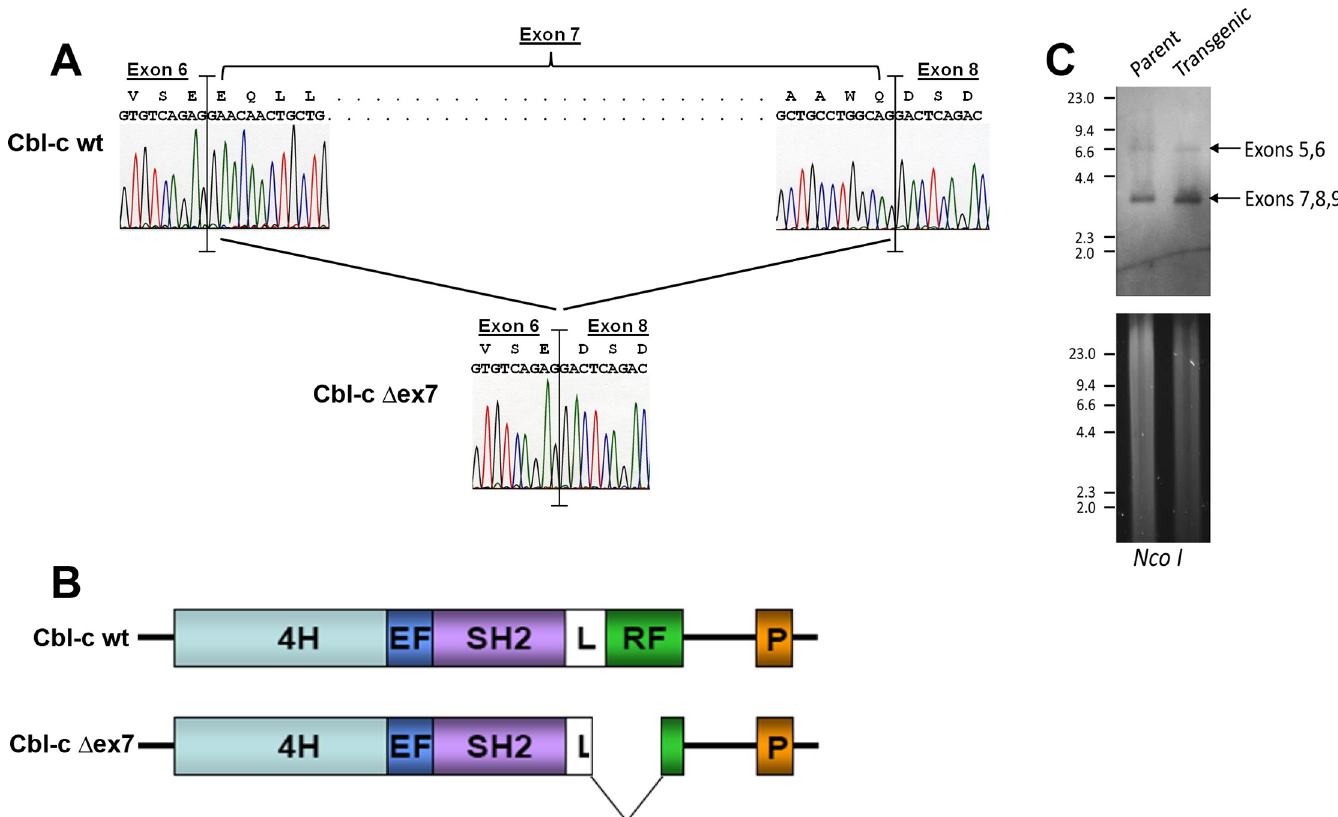
Fig 1. Structure of a Cbl-c mutant (Cbl-c Δ ex7) isolated from a mouse ductal carcinoma. (A) Sequence analysis of Cbl-c wildtype and Cbl-c Δ ex7. Sequence for wild type cDNA is shown on top of panel and sequence for mutant is shown on bottom demonstrating an in-frame deletion of exon 7 which encodes part of the linker domain and the catalytic RING finger domain. (B) Cartoon depicting structural comparison of mouse wild-type and mutant mouse Cbl-c Δ ex7. (C) Genomic DNA from parental and transgenic mouse stocks were digested, as indicated, separated by electrophoresis, stained with cyber green (bottom panel), then transferred to nylon membrane (upper panel) and probed to detect regions flanking exon 7 of mouse Cbl-c. Arrows indicate the bands containing exons 5 and 6 and the band containing exons 7-9.DNA molecular weight standards in kilobases are indicated on the left of each panel.